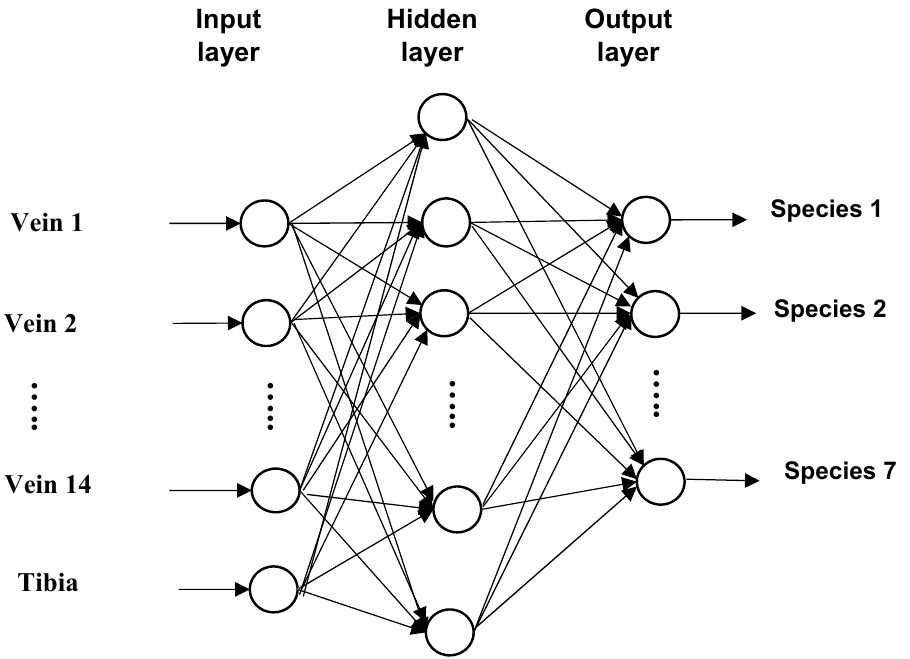
Figure 5. A schematic diagram illustrating the structure of a simple multilayer neural network. Arrows represent the direction that values are passed. At the end of the network, the output layer provides the probability that the specimen in question belongs to a given